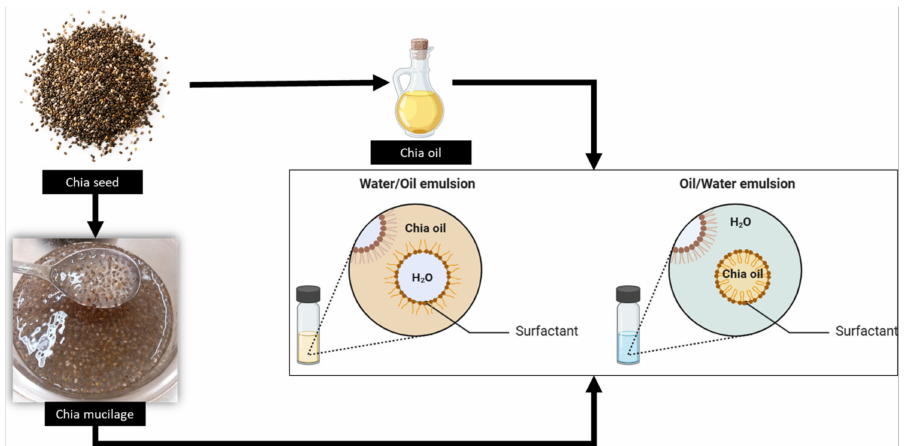
Figure 1. Scheme demonstrating chia seed and its products (oil and mucilage) and emulsion formation from